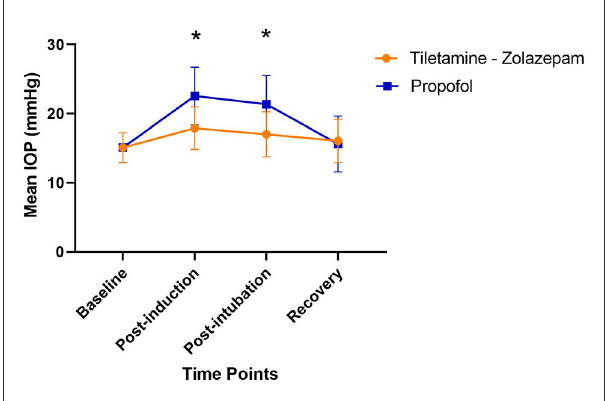
FIGURE1 Changes in mean IOP across the induction procedure when treated with tiletamine- zolazepam vs. propofol; * significant difference between groups ( p < 0.05). Tiletamine- Zolazepam: no significant difference over time; Propofol: post induction mean difference: 7.5 ± 4.2 1 [95%CI − 4.4 to − 9.5], Post intubation mean difference: 6.3 ± 4.9 [95%CI − 3.7 to − 7.8]; Tiletamine-zolazepam vs.